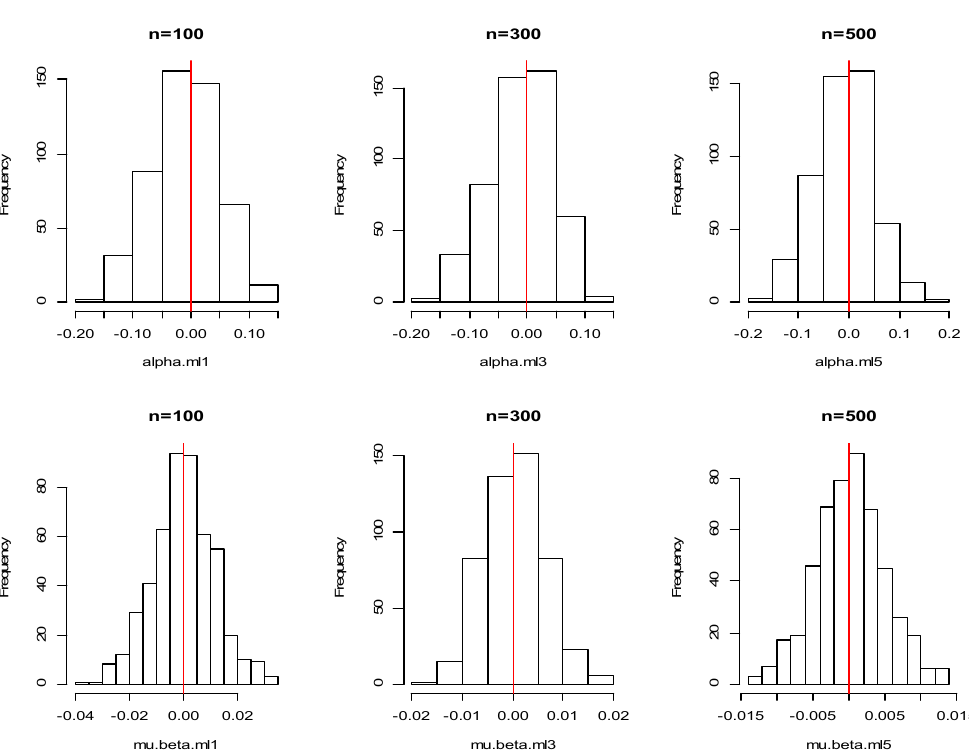
α μ and β with maximum likelihood method in Case 3 .